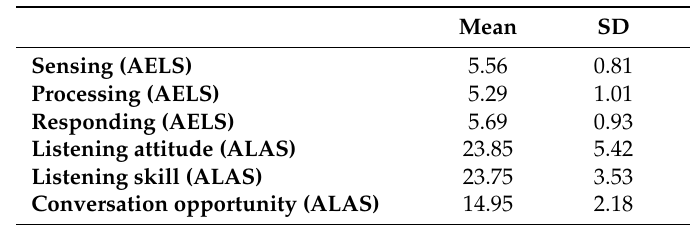
Table 3. Results from multiple linear regression analysis for AELS dimensions.